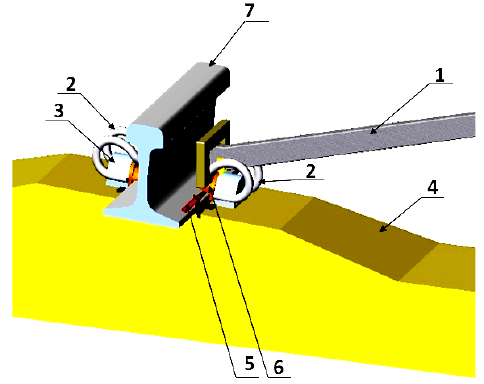
Fig. 2. Working position of the rail device for measuring the pressing force of the terminal to the rail: 1 – track device; 2 – elastic terminal; 3 – anchor embedded in the crosstie; 4 – crosstie; 5 – measuring probe; 6 – polymeric bearing; 7 – rail